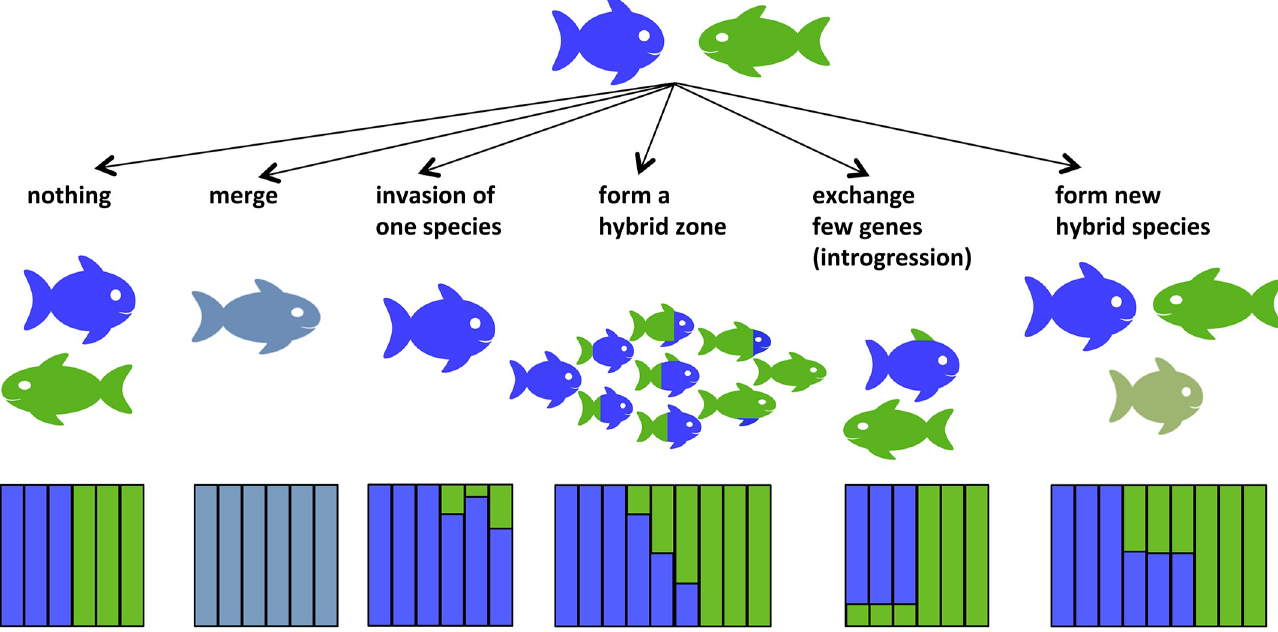
Fig 1. Potential evolutionary outcomes of hybridization. While most hybridization events are evolutionary dead ends, hybridization may also lead to speciation reversal where two taxa merge into one or form a hybrid zone between parapatric taxa. Alternatively, only one species may disappear through genetic swamping if introgression is highly asymmetrical. When one or few heterospecific alleles are advantageous these can also introgress into one of the parent species’ genomes through repeated backcrossing. Hybrids may also form novel lineages that are reproductively isolated from both parent taxa. The coloured fractions of the bars in the bar plots below show the relative proportion of the genome belonging to the blue and green parental lineages respectively. The grey bars represent a speciation reversal where differences are selected against. Finally, if hybridization leads to unfit offspring, it may reduce the fitness of the involved parental taxa due to wasted reproductive effort and may increase extinction risks for